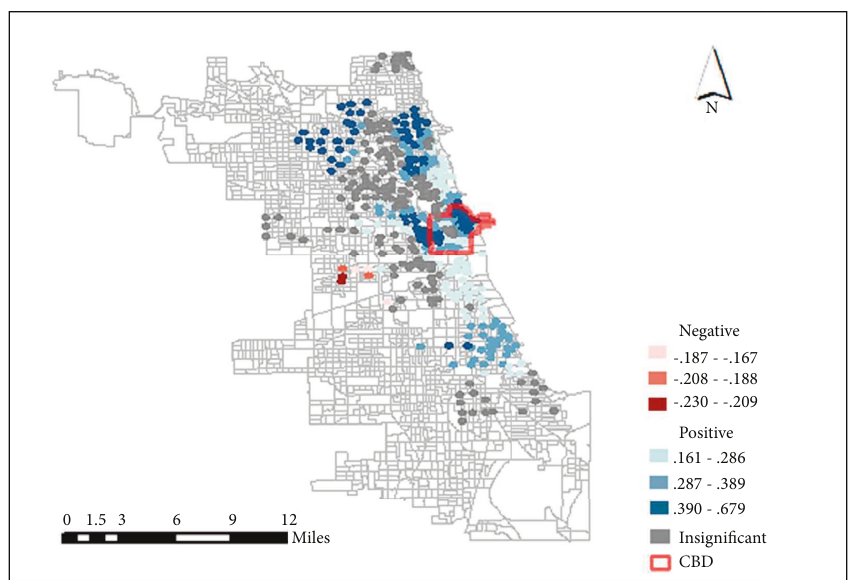
Figure 9: Distribution of household density regression coefficients.